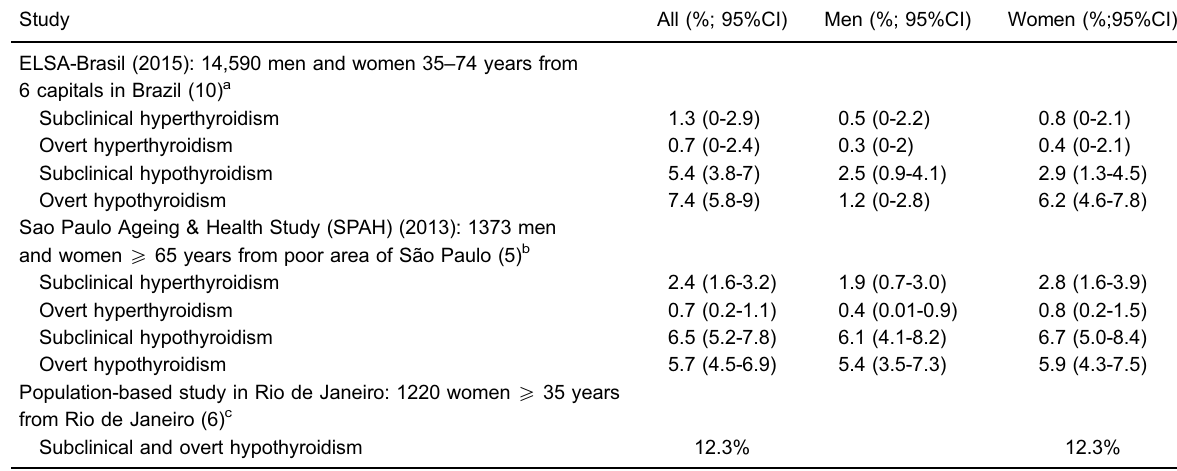
Table 1. Prevalence of thyroid disorders by sex in large, population-based